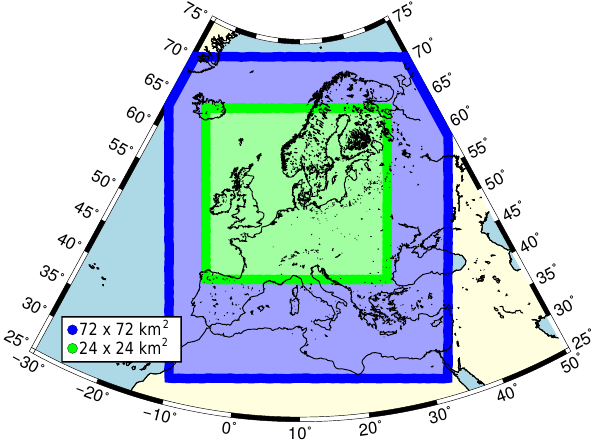
Figure 1. Study region and size of the model grids. The coarse grid (blue) includes Europe and parts of northern Africa. The first nested grid (green) includes northwestern Europe, including the North and Baltic